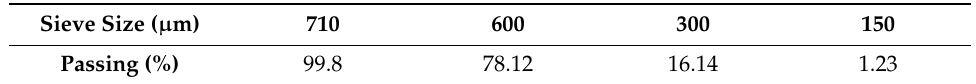
Table 2. Gradation of silica sand.